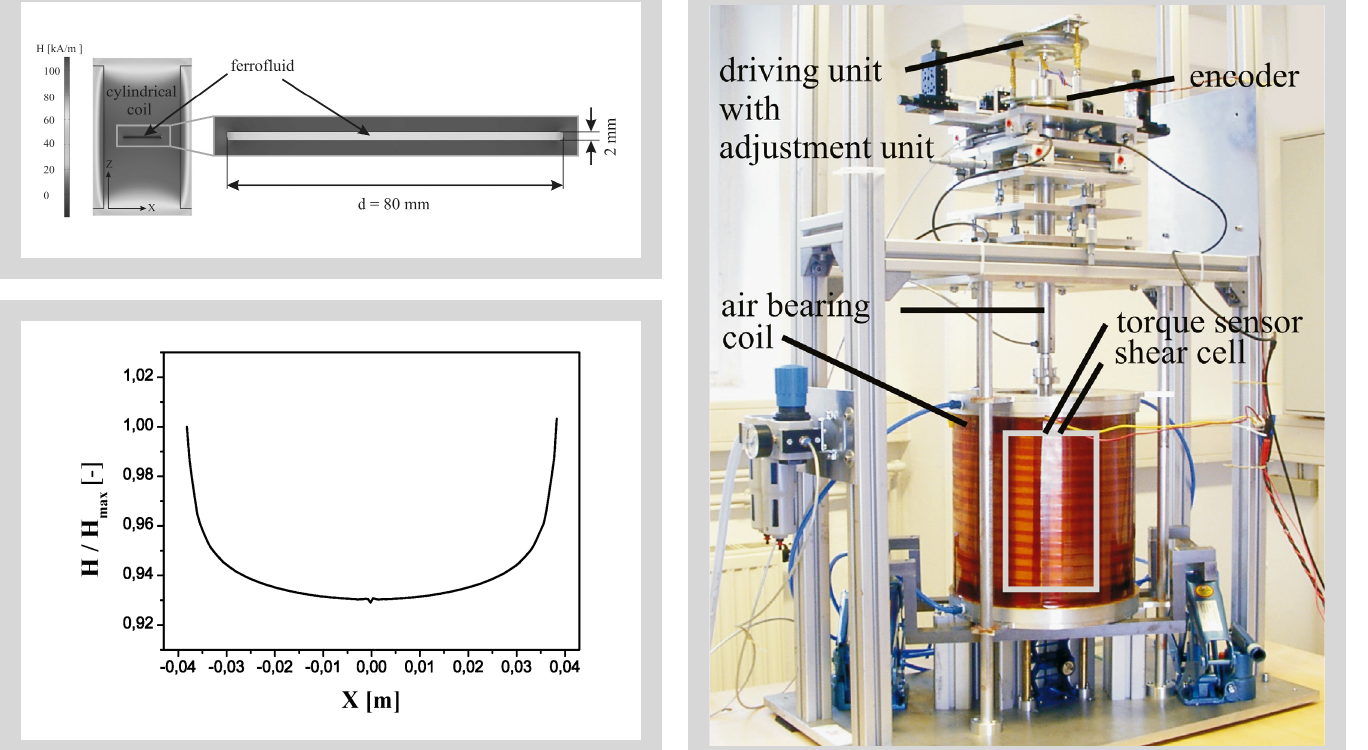
Figure 3 (left above): Magnetic field distribution simulated by Femlab for an intensity of electric current of about 5 A. Ferrofluid is indicated schematically in the center of the coil. Figure 4 (left below): The normalized magnetic field strength inside the fer- rofluid. Here x represents the radial position relative to the axis of rotation. x = 0 is the center of the fluid sample in the x-direction. Figure 5 (right): The shear stress controlled rheometer is used for the direct measurements of the yield stress in MR fluids as well as for